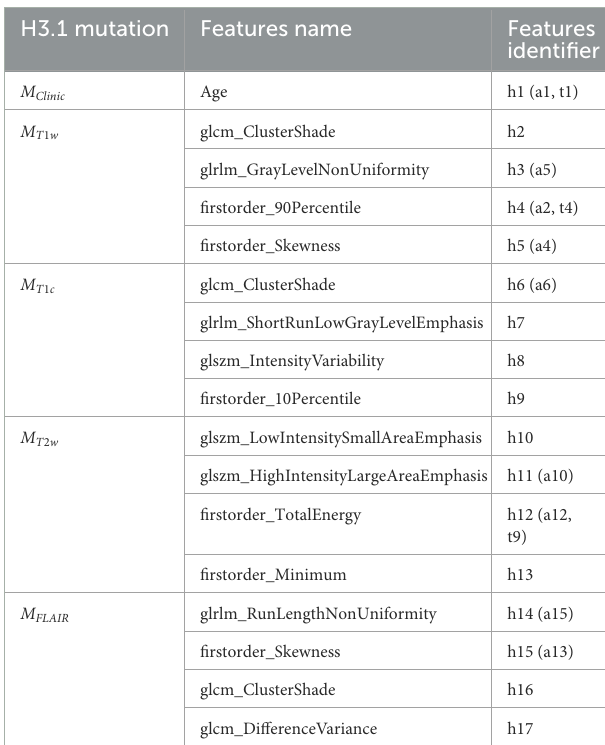
TABLE 3 Subsets of features selected by the five different models M Clinic , M T 1 w , M T 1 c , M T 2 w , and M FLAIR to predict H3.1 mutation.